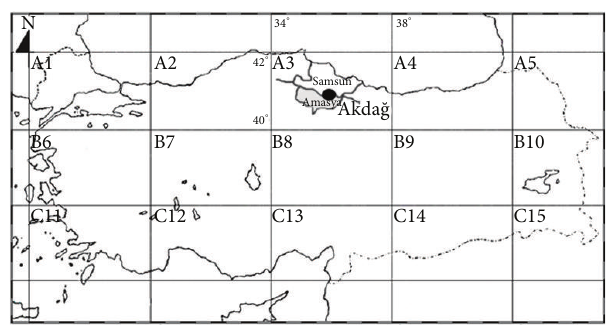
Figure 1: Amasya Akda˘g and Henderson’s grid system.